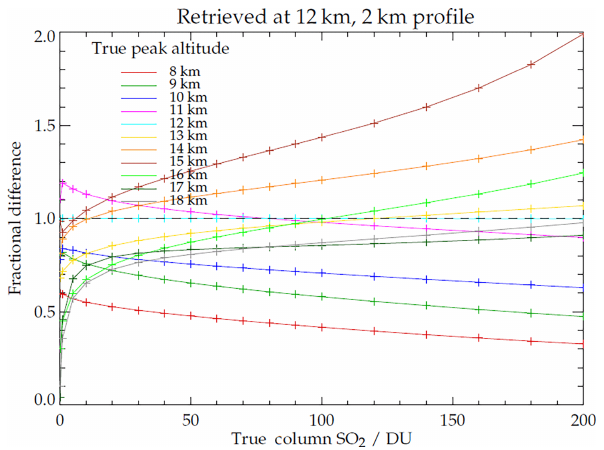
Figure 3. A measurement was simulated for a volcanic plume of triangular profile centred at a range of altitudes, for a range of total column amounts. A retrieval is then performed where the plume is assumed to be at 12km. The fractional difference, or error, is plotted.